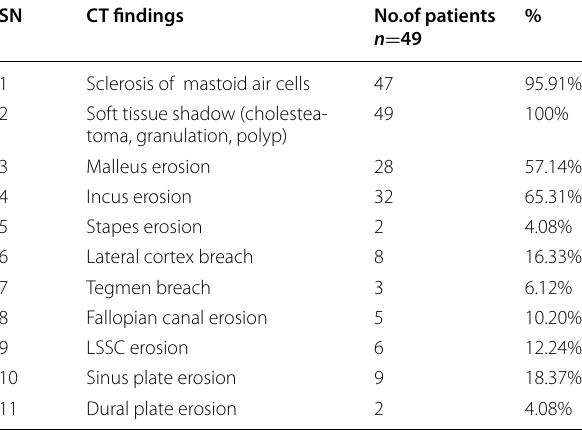
Table 1 Preoperative CT findings